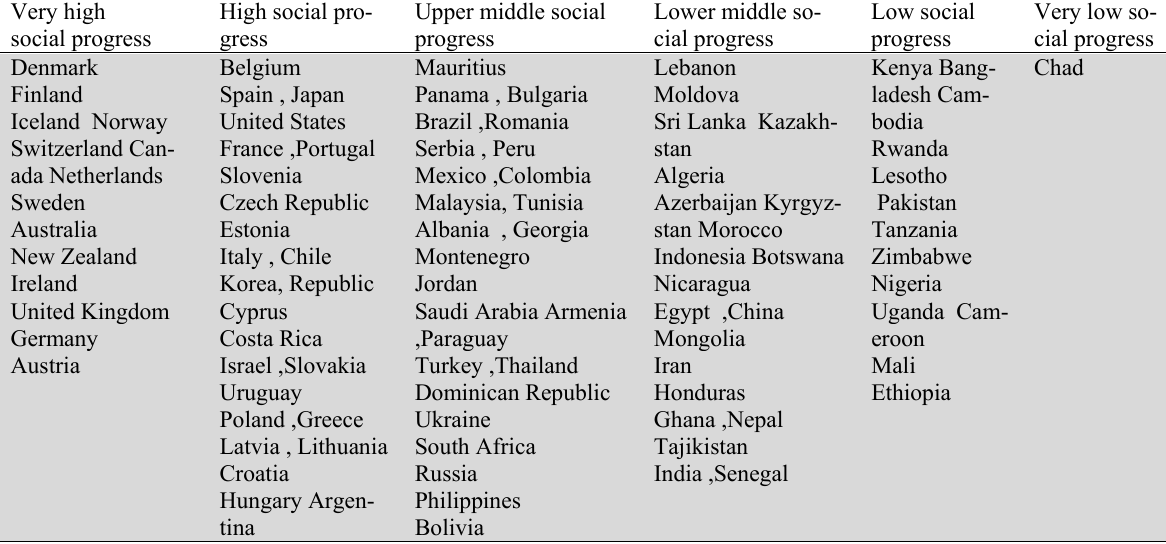
Countries included in the study organized into the tiers of SPI (2017) Very high social